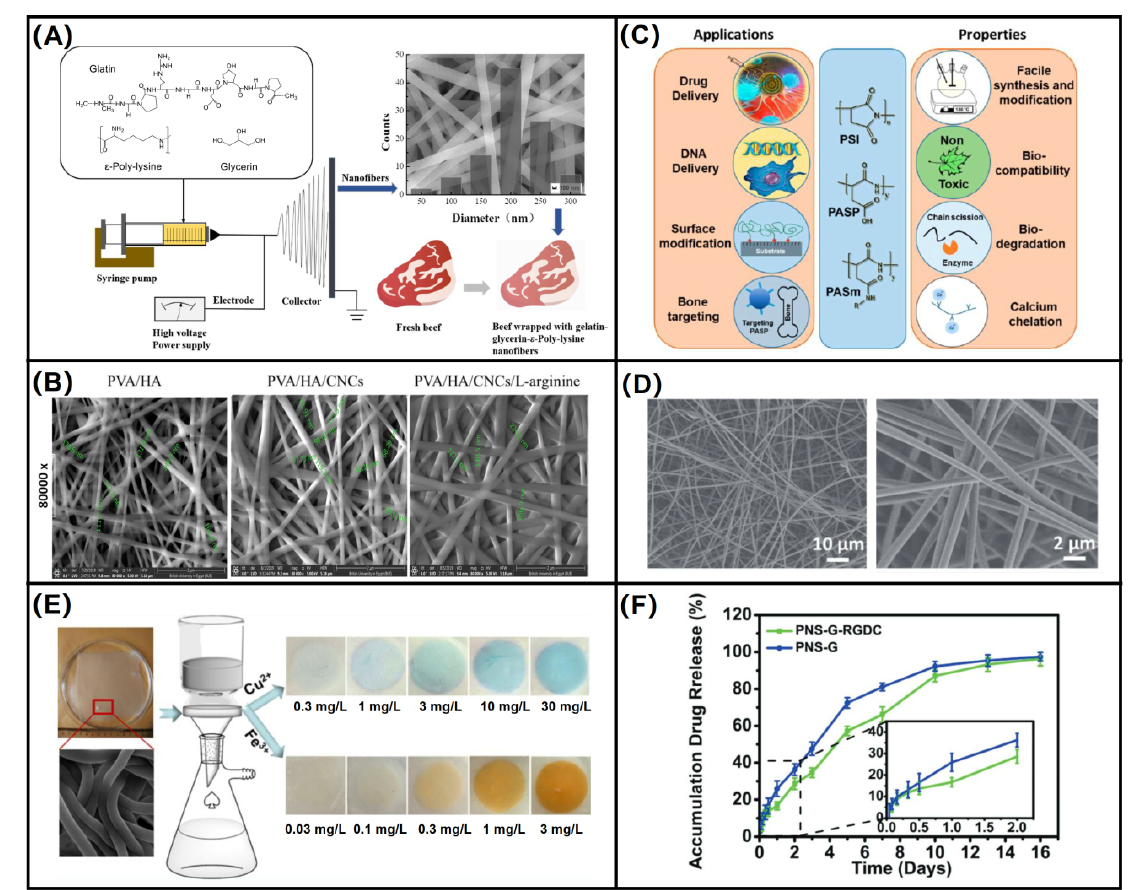
Figure 7. Preparation and application of polar amino acid electrospun nanofibers. ( A ) Electrospun gelatin-glycerin- ε -poly-lysine nanofibers [95]; ( B ) SEM images of selected PVA/HA, PVA/HA/CNCs, and PVA/HA/CNCs/L-arginine NFs scaffolds [98]; ( C ) properties and biomedical applications of poly(aspartic acid) and its derivatives [111]; ( D ) SEM image of electrospun nanofiber [114]; ( E ) application of procedure of PASP [112]; ( F ) Release curve of GS-Rg3 from fiber